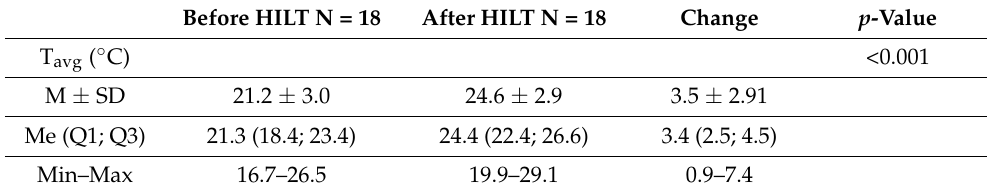
Table 2. Significance of differences in mean temperatures before and after high-intensity laser therapy. Before HILT N = 18 After HILT N = 18 Change p -Value T avg ( ◦ C) <0.001 M ± SD 21.2 ± 3.0 24.6 ± 2.9 3.5 ±